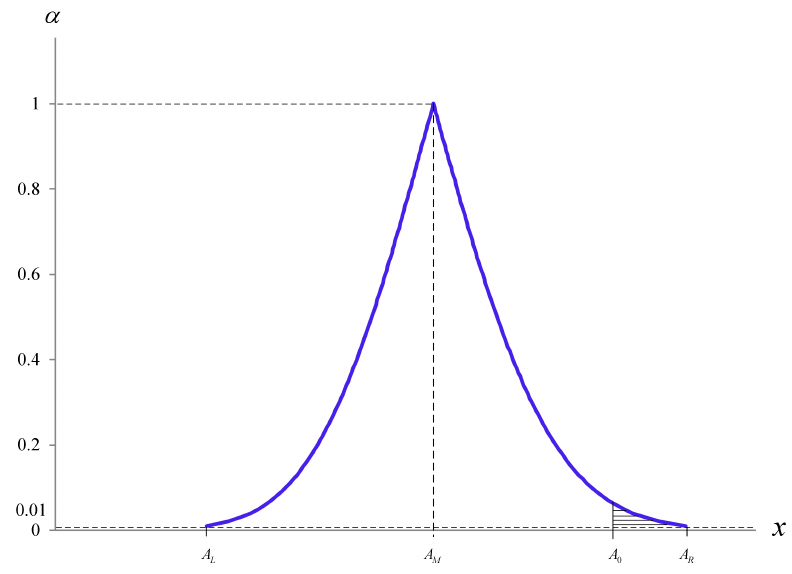
( x ) with vertical line x = A